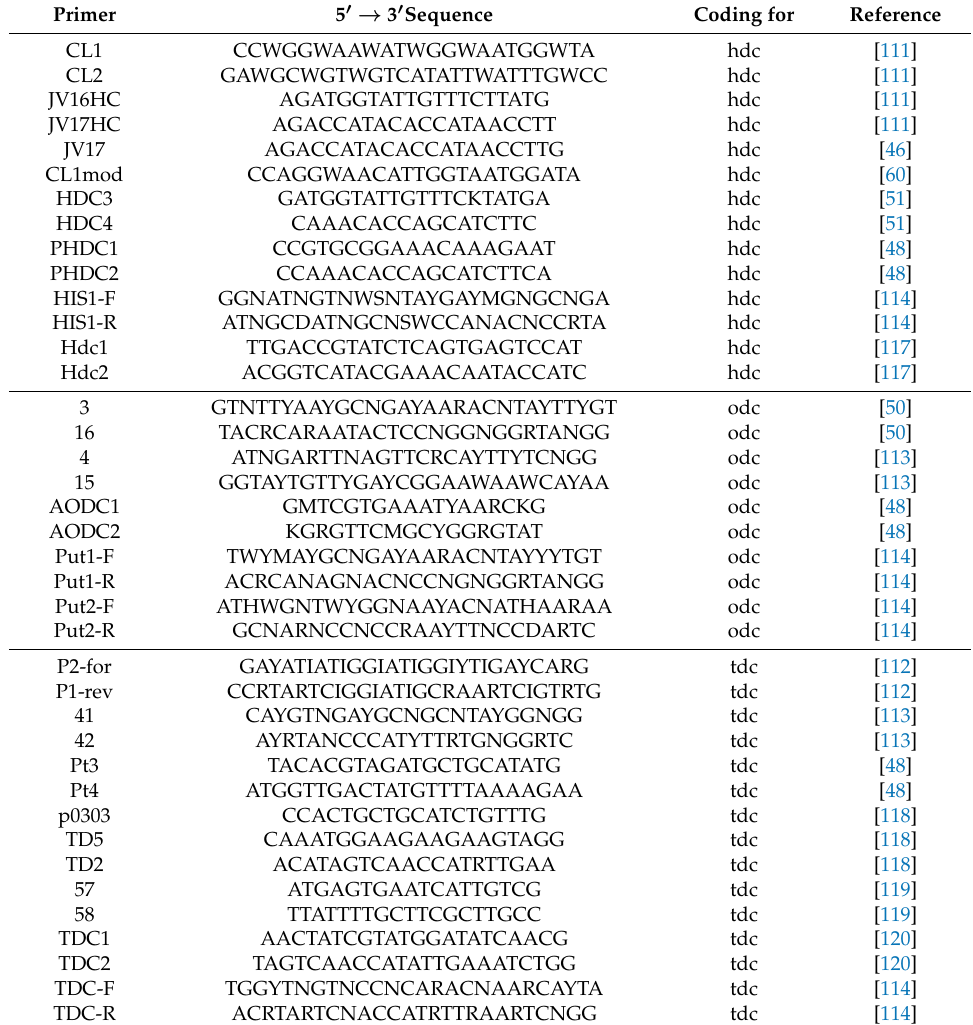
Table 4. List of the primers described in literature for the detection of decarboxylase genes (hdc, odc, tdc) . Primer 5 (cid:48) → 3 (cid:48) Sequence Coding for